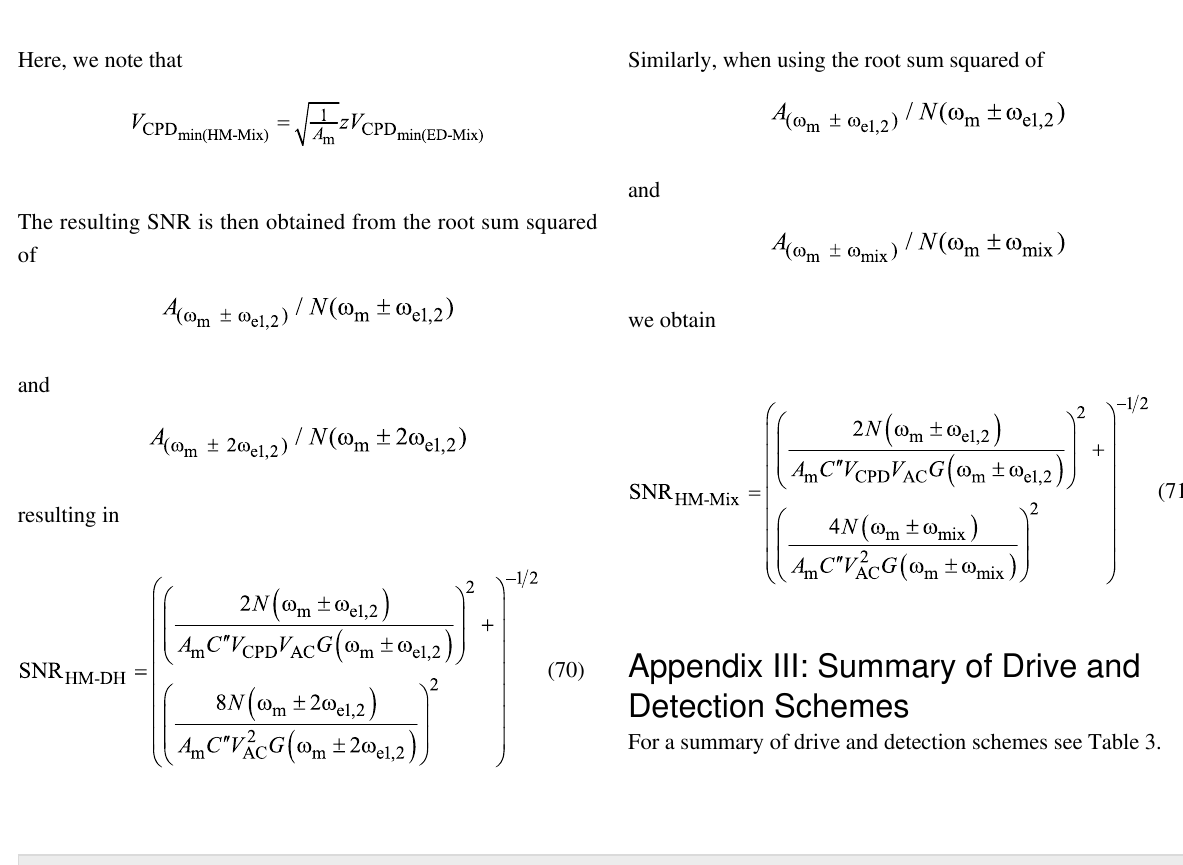
Table 3: Summary of drive and detection (Det.) schemes. a